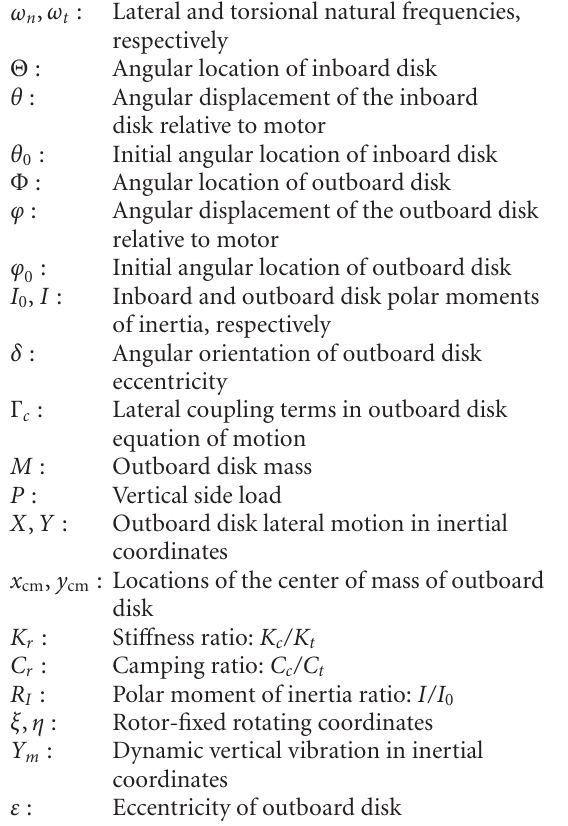
responses occurring at fixed noninteger values of the lateral natural frequency. Orbit plots can also be used to identify a crack with patterns distinguishable from other geometric asymmetries. The distinct vibration signatures predicted by this model can be used for shaft crack diagnostic